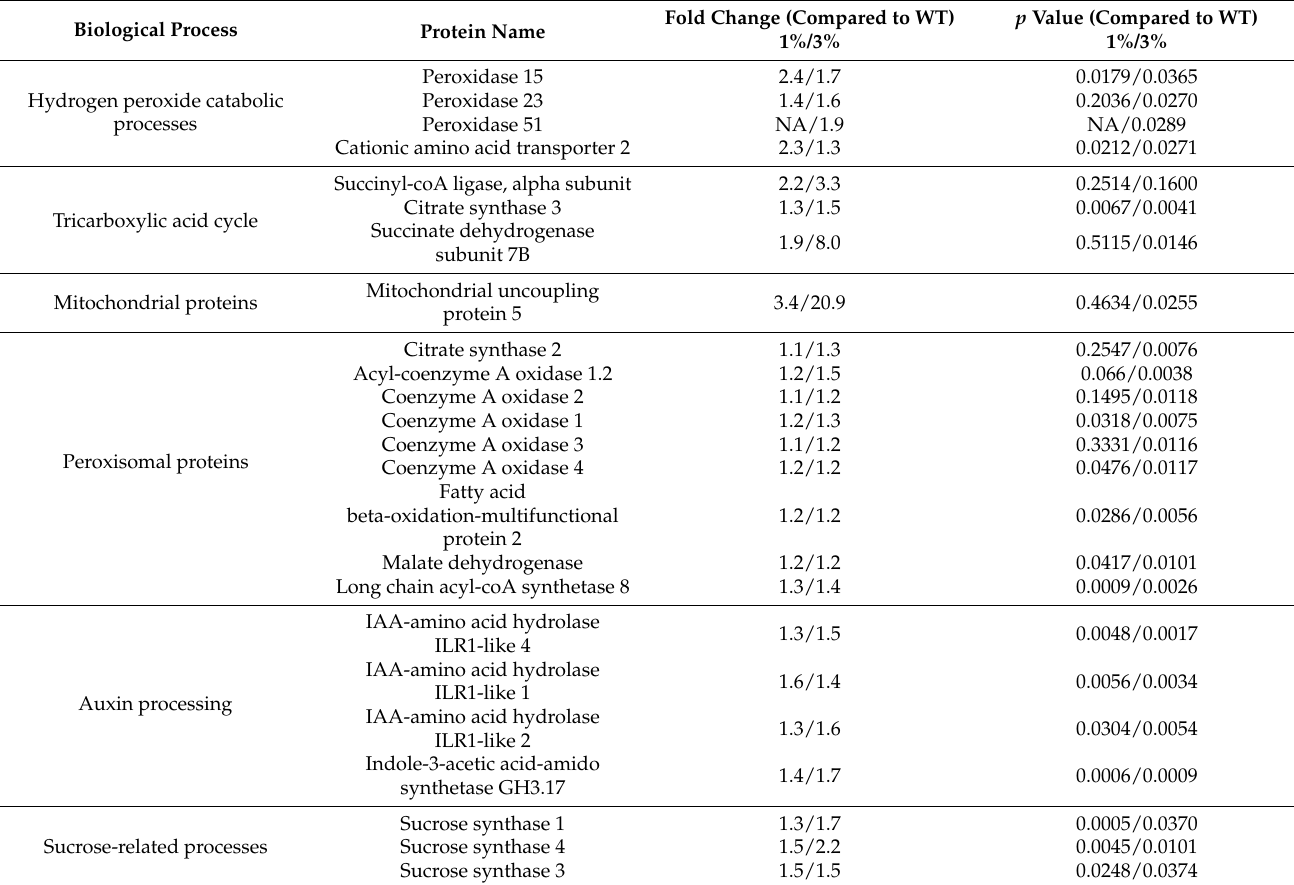
Table 2. Selected proteins upregulated in roots of atg5-1 seedlings under different sucrose